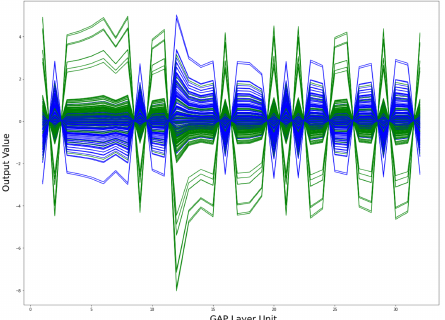
Figure 9. Global average pooling layer output providing the full test set as model input. In this case some errors are visible (i.e., green lines in blue-line zone and vice versa). It is worth noting that errors in detection are often near to 0 values output. This might suggest that the 0.0 threshold value used to separate the classes is small and this could possibly explain model